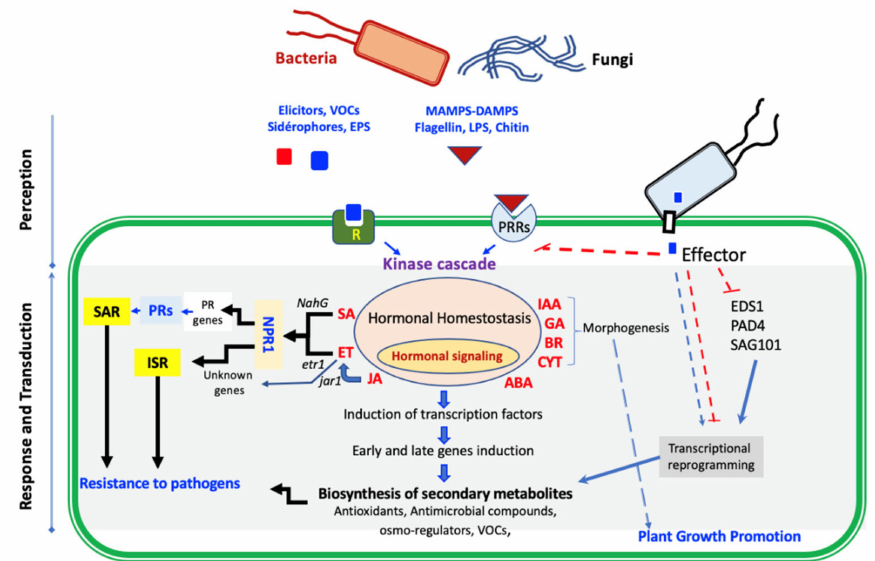
Figure 3. Schematic model of signal transduction events triggered by microbes. Microbes may produce microbe-associated molecular patterns (MAMPs) or damage-associated molecular patterns (DAMPs), such as flagellin or chitin, which are perceived by pattern-recognition receptors (PRRs), or other elicitors, such as volatile organic compounds (VOCs), or siderophores, which are perceived by receptors. The activated receptors may then trigger different signaling cascades, acting as a precursor for the biosynthesis of phytohormones that trigger defensive pathways. The kinase cascade may also phosphorylate transcription factors that modulate the expression of early and late response